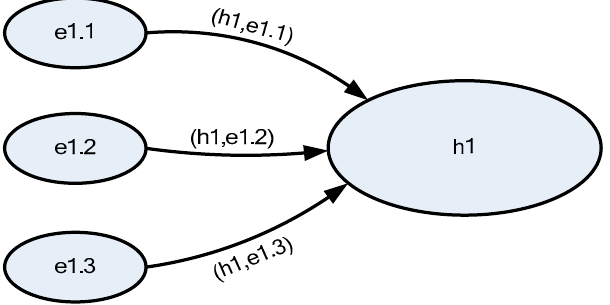
Figure 6. Model for intermediate hypothesis h1.